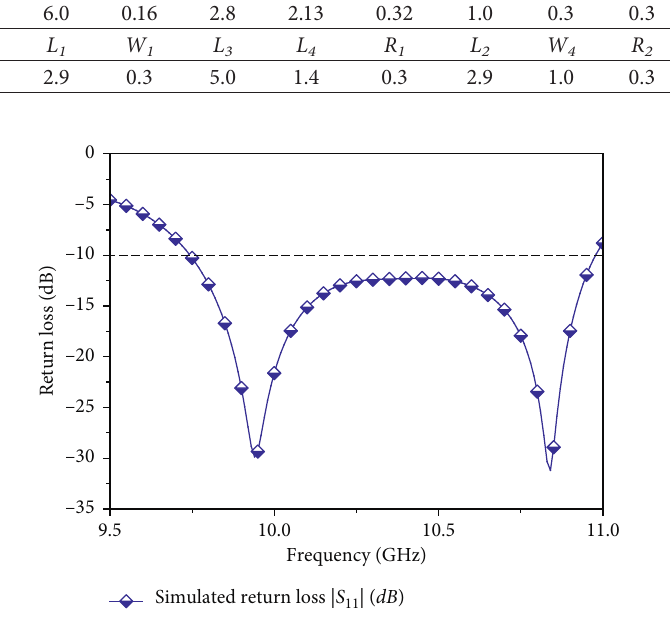
Figure 2: The return loss performance of developed prototype across the frequency span.